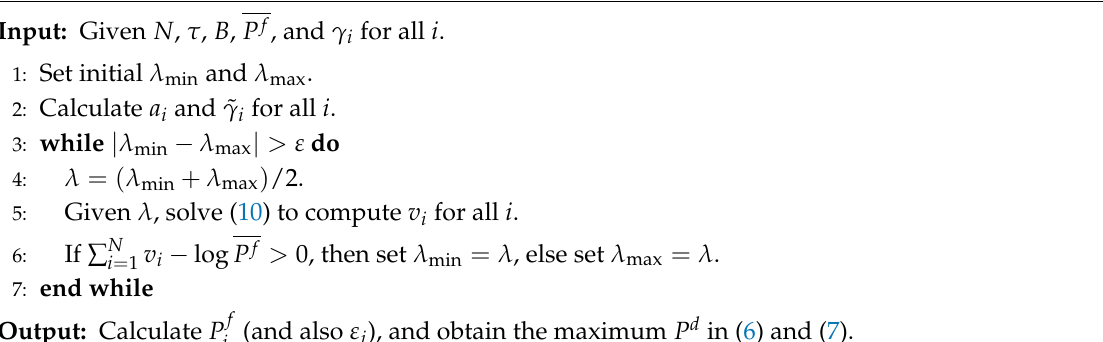
Algorithm 1 : Find the globally optimal v ∗ and λ ∗ for